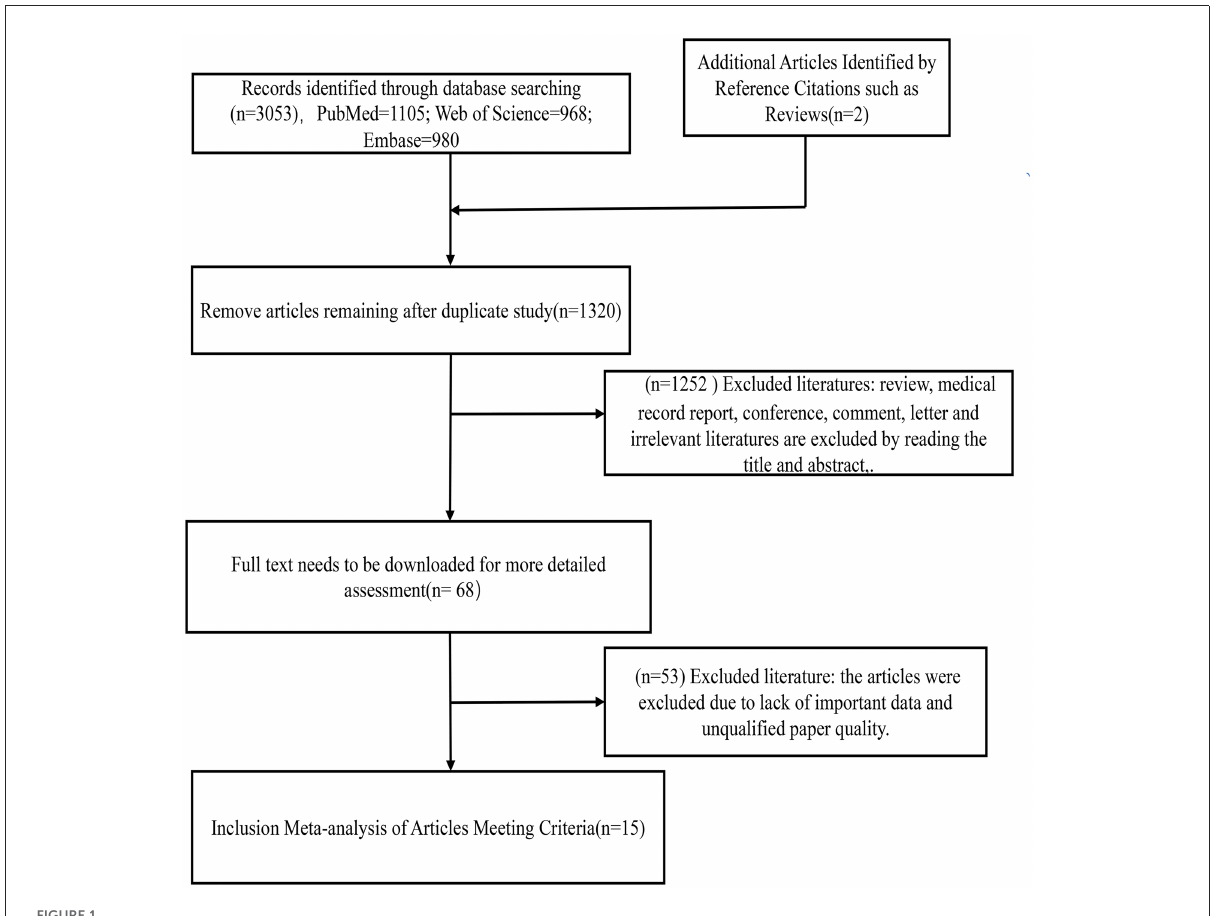
FIGURE1 Flow diagram of this